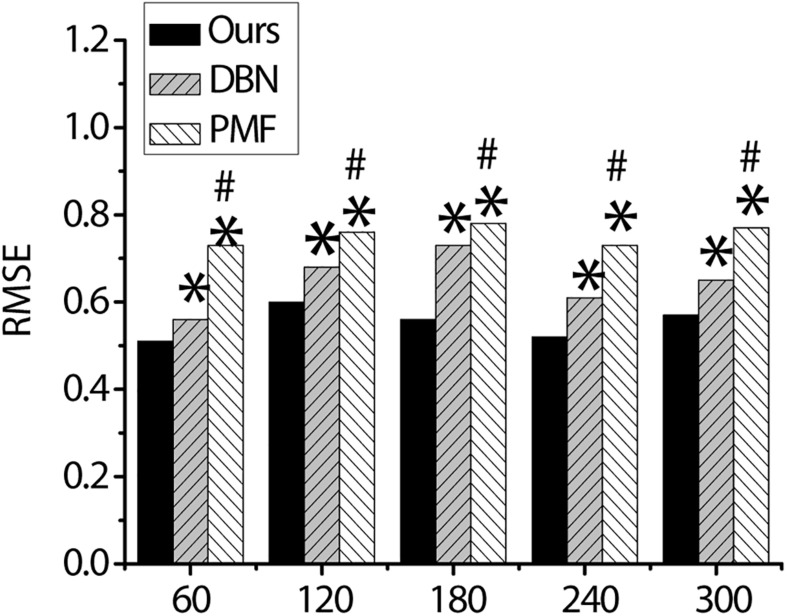
The MSE of the three algorithms. ∗ indicates that the difference is statistically significant compared with the algorithm proposed in the study (p < 0.05). # indicates that the difference is statistically significant compared with DBN algorithm (p < 0.05).